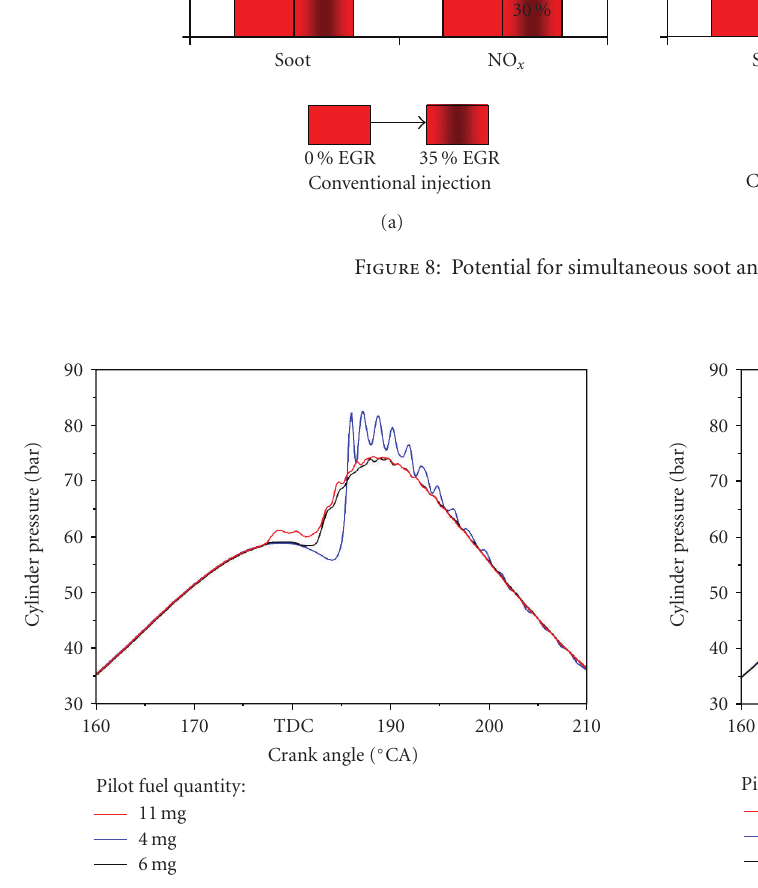
Figure 9: Cylinder pressure with conventional pilot injection. Figure 10: Cylinder pressure with spatial separation of pilot and main